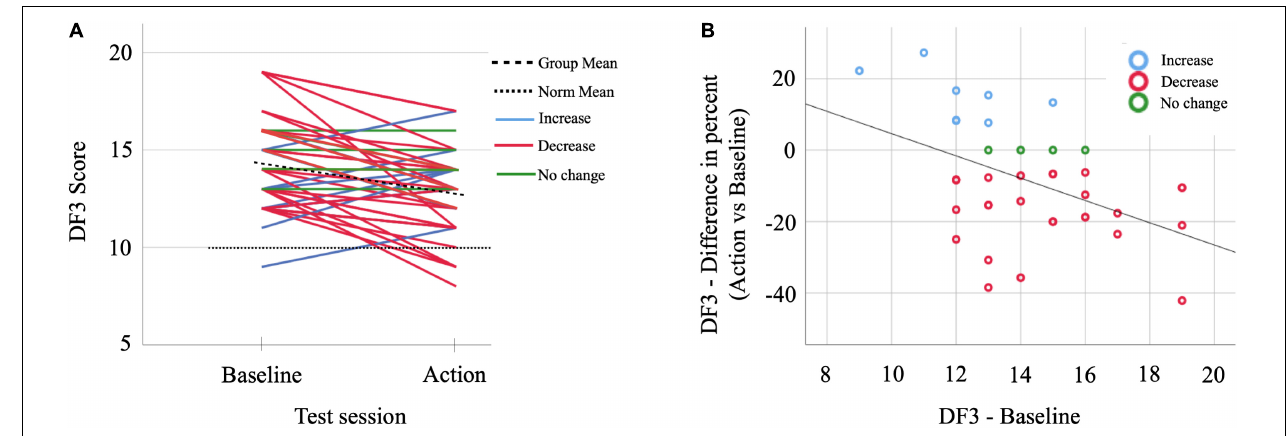
FIGURE 2 | (A) The DF3 results from the baseline measurements and from the stress test for all NIA participants. (B) The difference in DF3 results between baseline and stress test in percent change as compared to baseline scores for all NIA